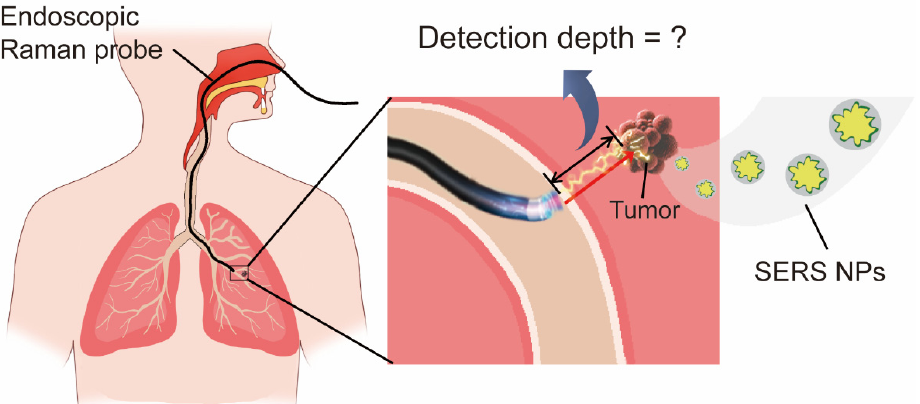
Figure 1. Schematic diagram of Raman-guided bronchoscopy in detecting lung tumors with the use of SERS NPs. of SERS